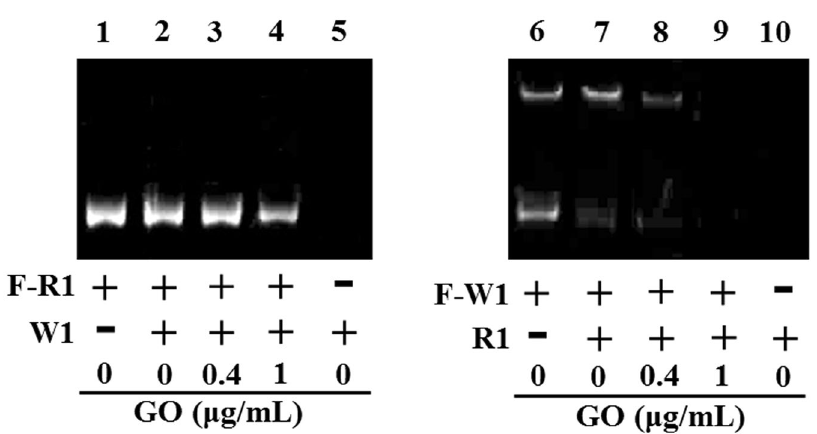
Figure 4. The effect of GO on DNA amplification in a semimultiplex PCR with a forward primer and two reverse primers (F-R1 + W1 and R1 + F-W1). F-R1 and F-W1 were labeled with TAMRA fluorochrome at 5 ′ end. The final concentrations of R1 and W1 were 20 nM. PCR products were analyzed by agarose gel electrophoresis (1.5%). Lane M is